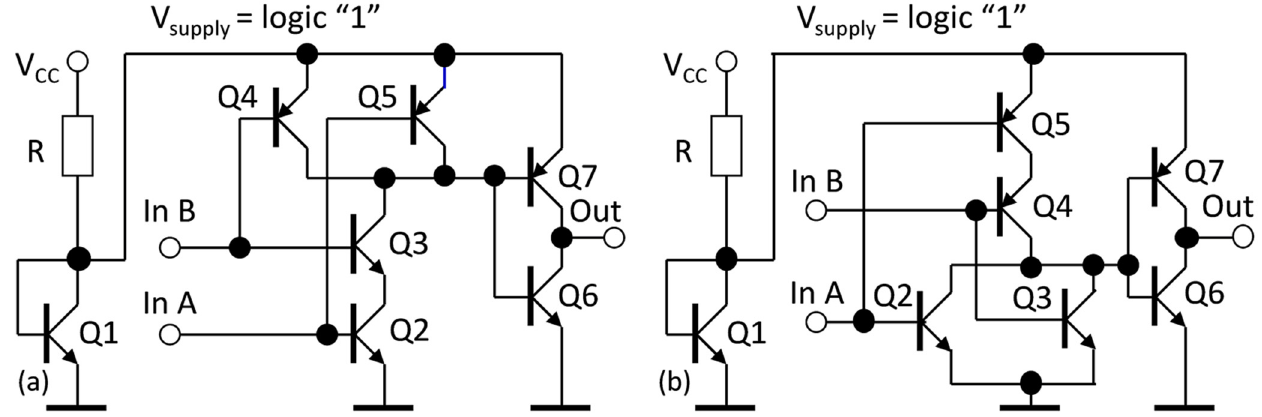
Figure 14. Thermally stabilized CBip gates. ( a ) AND gate; ( b ) OR gate.